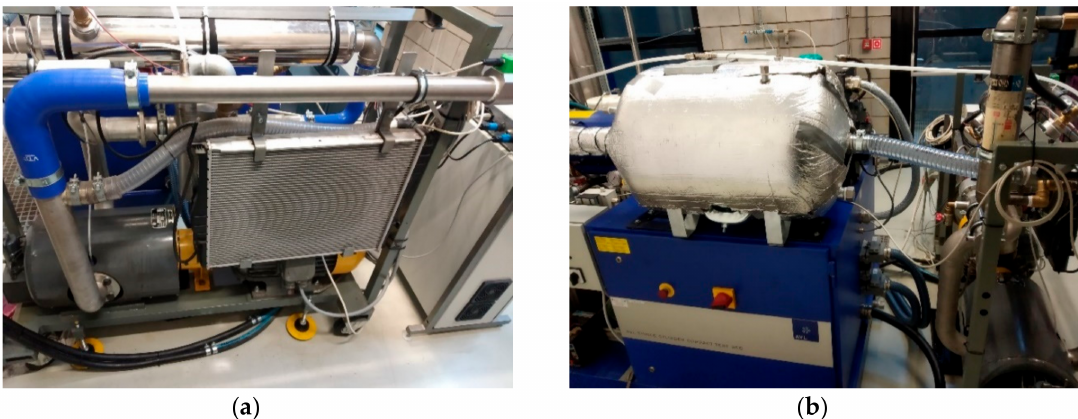
Figure A1. Overall view of the 5402 AVL engine test stand.